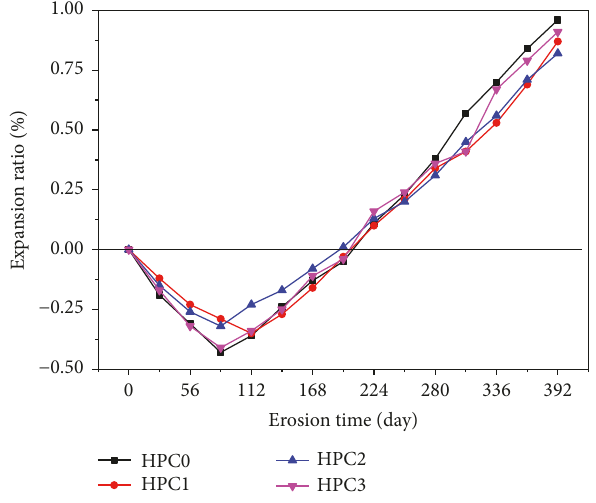
Figure 4: Expansion ratio of HPCs at various erosion